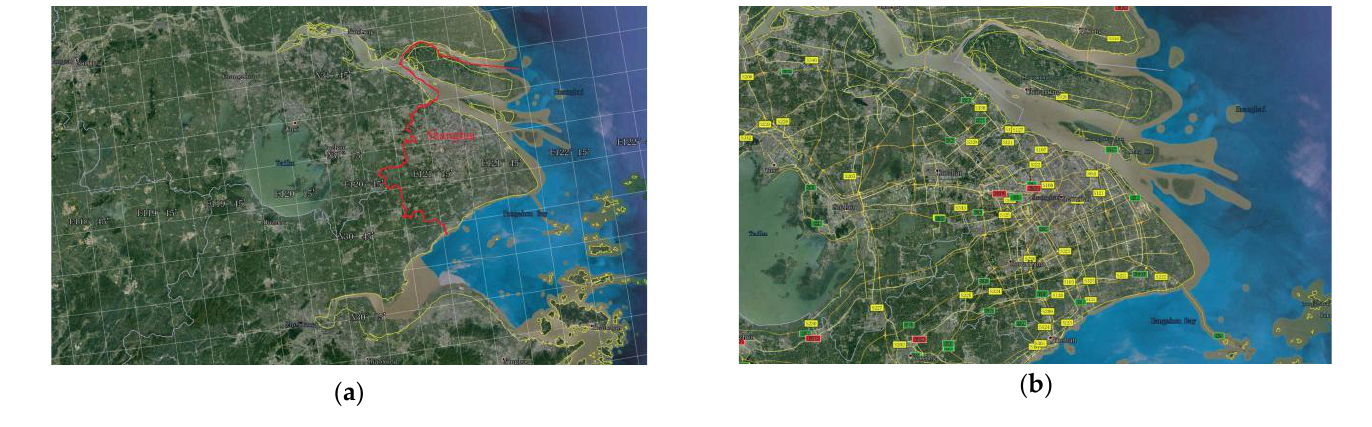
Figure 1. Location and traffic network of Shanghai. ( a ) Shanghai location. ( b ) Shanghai traffic arterial network map.